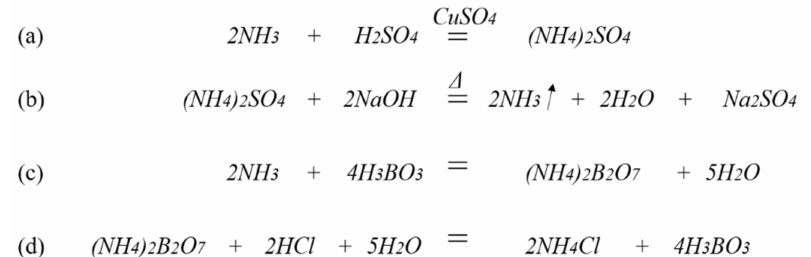
Scheme 1. Reaction mechanism of the Kjeldahl method.